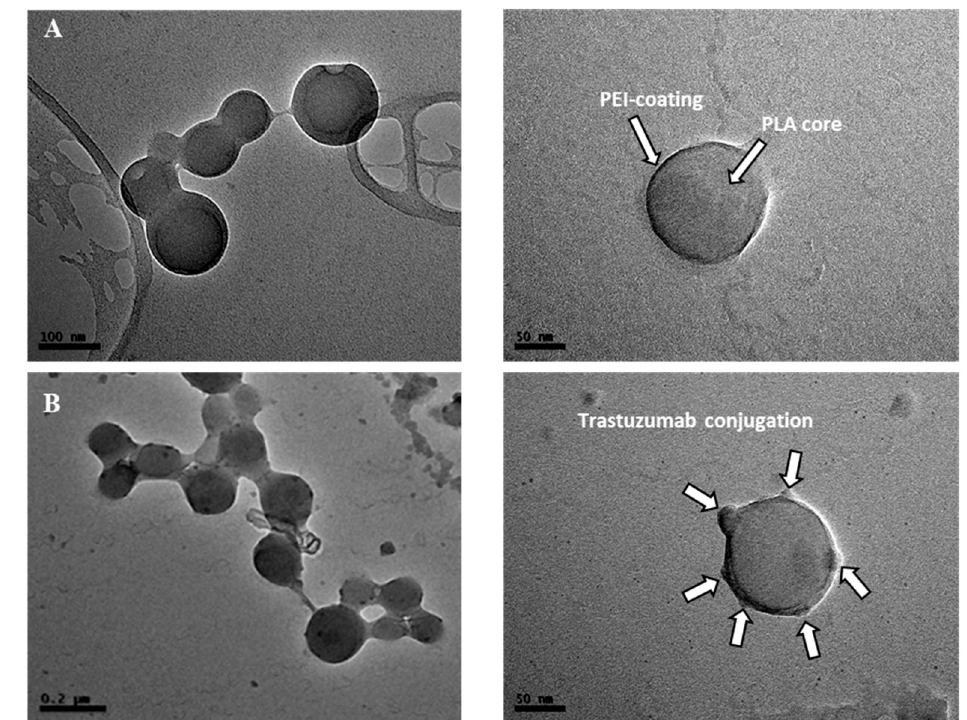
Figure 1. TEM images of ( A ) MZ1-NPs and ( B ) MZ1-ACNPs.